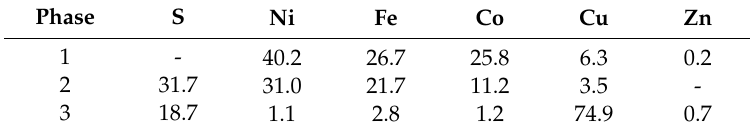
Table 5. Average concentrations (wt %) of elements in phases 1–3 indicated in Figure